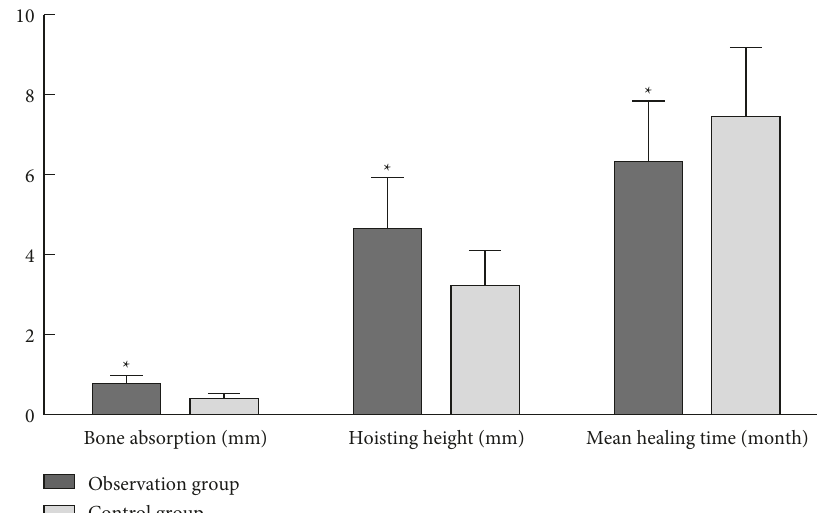
Figure 2: Comparison of bone binding indexes between the groups treated with maxillary sinus external/internal lift. Note. Compared with the group treated with maxillary sinus external